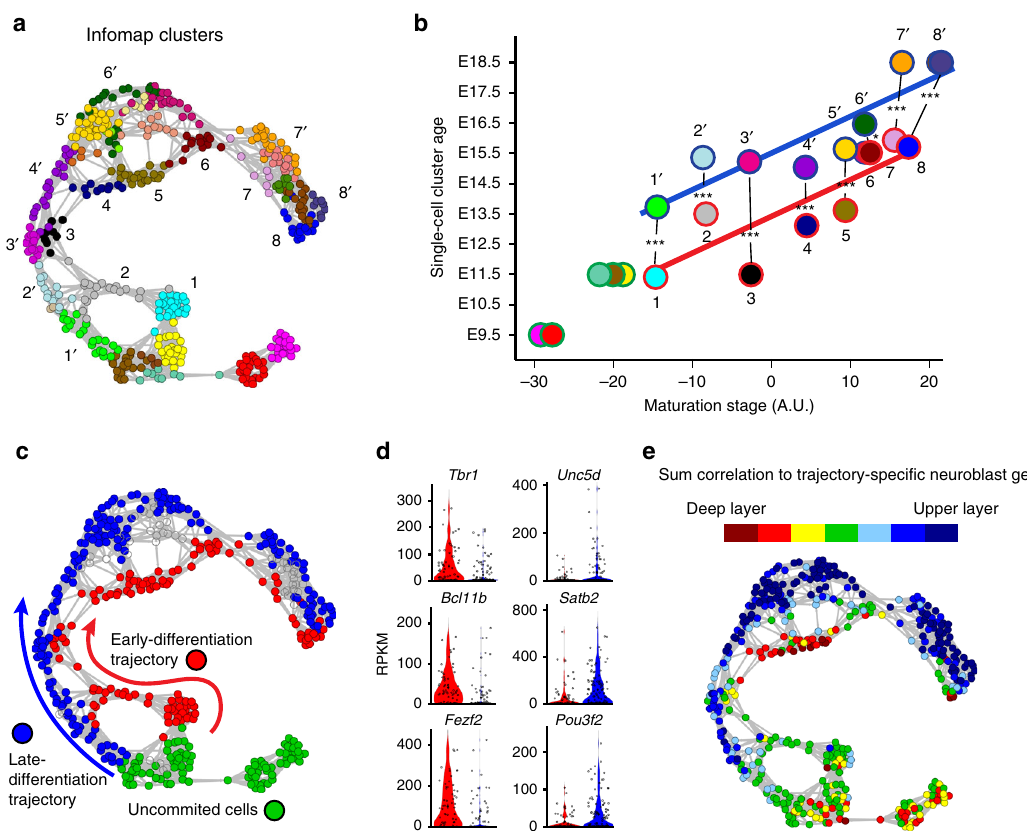
Fig. 2 Identi fi cation of temporally distinct cortical differentiation trajectories. a t SNE-NN map coloured by Infomap clusters. Numbering indicates maturation-stage matched clusters. b Numbered and colour-coded circles represent average values for Infomap clusters displayed in ( a ). The Infomap clusters are based on the following number of cells; cluster 1 25 cells, cluster 1´ 21 cells, cluster 2 19 cells, cluster 2´ 14, cluster 3 9 cells, cluster 3´ 14 cells, cluster 4 10 cells, cluster 4´ 21 cells, cluster 5 30 cells, cluster 5´ 21 cells, cluster 6 14 cells, cluster 6´ 20 cells, cluster 7 7 cells, cluster 7´ 21 cells, cluster 8 15 cells and cluster 8´ 8 cells. Infomap clusters are plotted based on their embryonic age and maturation-stage values, with best- fi t lines for Infomap clusters of early-differentiation (red) and late-differentiation (blue) trajectories. P -values for the Infomap cluster comparisons; 1 vs. 1´ (1.34e-9), 2 vs. 2´ (1.38e-6), 3 vs. 3´ (6.63e-11), 4 vs. 4´ (1.35e-5), 5 vs. 5´ (6.30e-12), 6 vs. 6´ (1.59e-2), 7 vs. 7´ (9.65e-4), 8 vs. 8´ (2.32e-4). c t SNE-NN map depicting uncommitted cells (green), and cells committed to the early-differentiation (red) or late-differentiation (blue) trajectories. d Violin and dot plots of deep- ( Tbr1 , Bcl11b and Fezf2 ) and upper-layer gene expression ( Unc5d , Satb2 and Pou3f2 ) in cells of early- and late-differentiation trajectories, respectively. Analysis is based on 129 cells in early-differentiation trajectory, and 140 in late-differentiation trajectory. e t SNE-NN map showing sum correlation of each cell to deep- and upper-layer-trajectory neuron gene pro fi les. Red and blue colours indicate strong correlation to deep- and upper-layer-trajectory gene sets, respectively. Statistics based on two-tailed t tests; * P < 0.05, *** P <